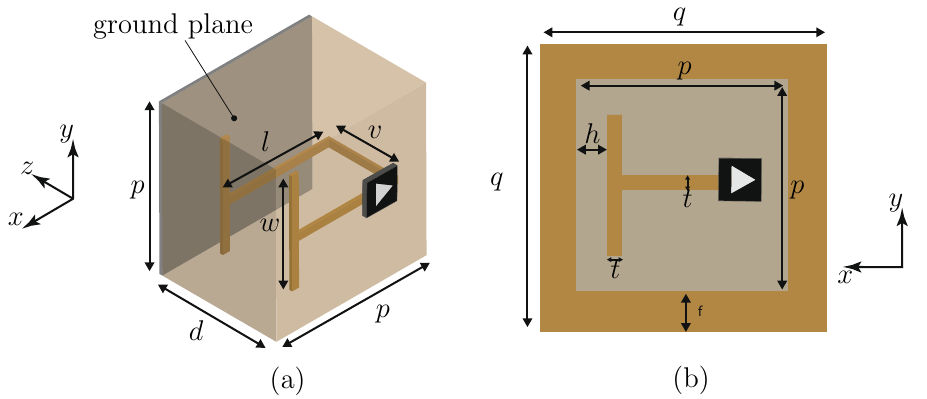
Figure 3. Unit cell corresponding to the metaparticle in Fig. 2, within a substrate of relative permittivity ǫ r = 4.5 , backed by a ground plane and with a front conducting frame. ( a ) Perspective view (without the front frame, for visibility). ( b ) Top